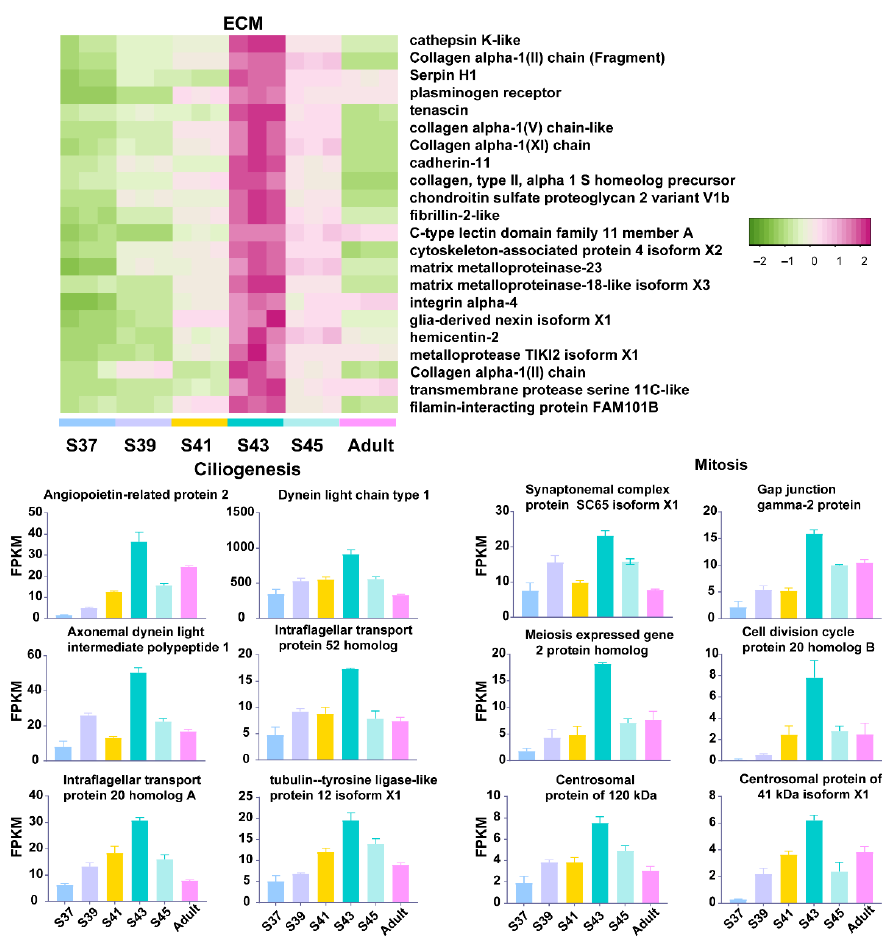
Figure 4. The variation patterns of featured genes involved in ECM construction, ciliogenesis and mitosis in the metamorphic climax phase ( n = 3 each stage).